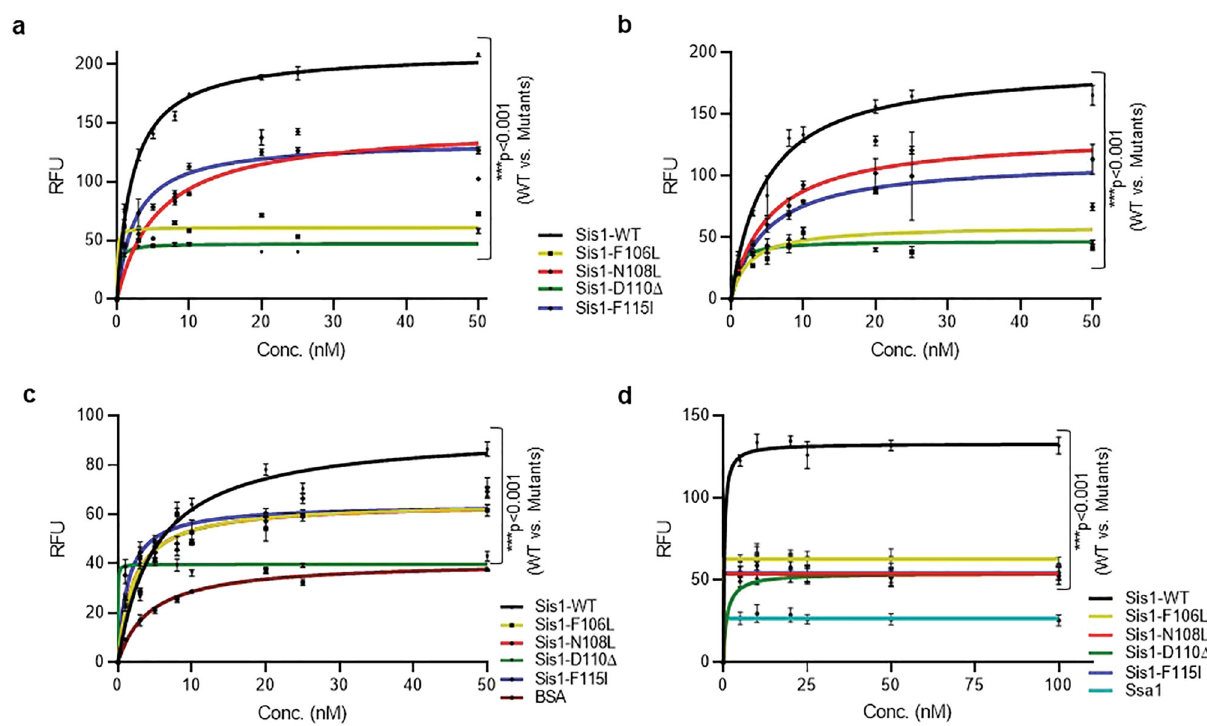
Fig. 4 | Sis1 binding to both substrate and Hsp70 is compromised in the pre- sence of LGMDD1 G/F domain mutants. Binding of puri fi ed Sis1-WT (black), Sis1- F106L (yellow), Sis1-N108L (red), Sis1-D110 Δ (green), or Sis1-F115I (blue) to dena- tured Rnq1 a and luciferase b . Rnq1 (400ng) and luciferase (100ng) were immo- bilized in microtiter plate wells and dilutions of puri fi ed Sis1-WT and Sis1-mutants (0,1,3,5,8,10,20,25,and50nM)wereincubatedwitheachsubstrate.Theamount of Sis1 retained in the wells after extensive washings was detected using a Sis1 speci fi c antibody. For c ; Ssa1 (200nM) was immobilized in microtiter plate wells and dilutions (0, 1, 3, 5, 8, 10, 20, 25, and 50nM) of puri fi ed Sis1-WT (black), and Sis1-mutants (Sis1-F106L (yellow),Sis1-N108L (red), Sis1-D110 Δ (green),or Sis1-